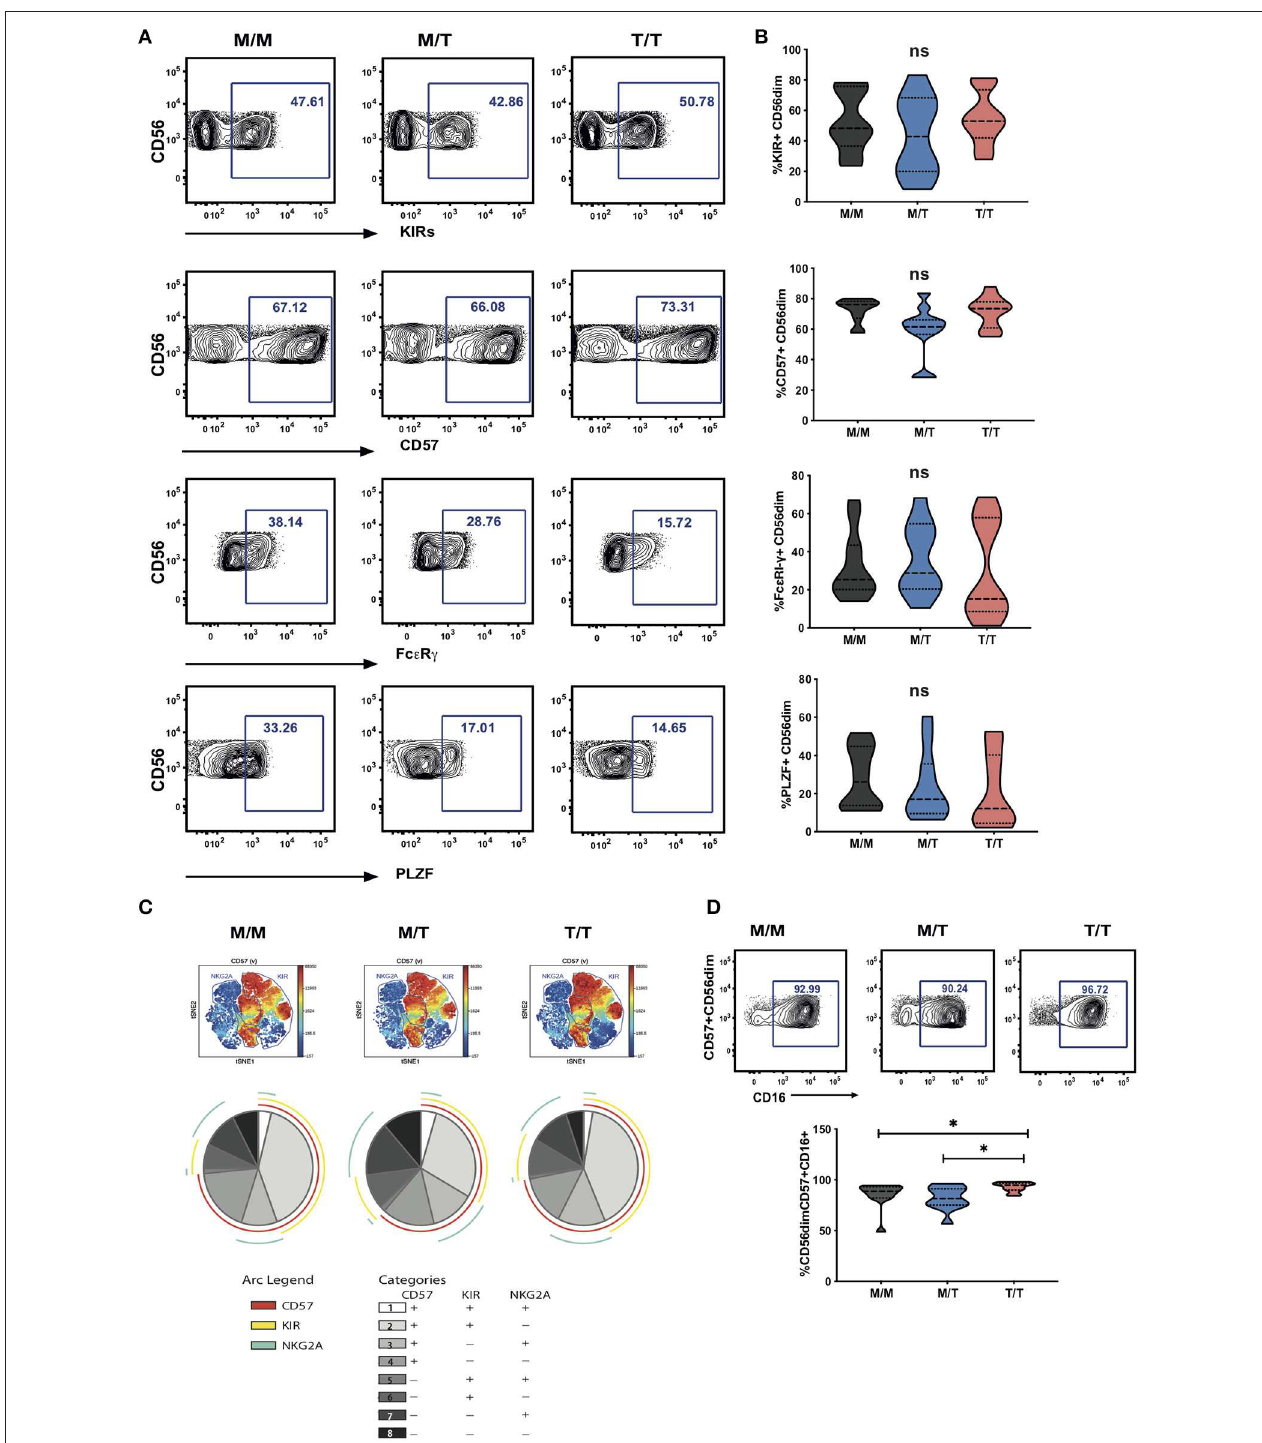
FIGURE 3 | Lack of a dominant effect of -21M HLA-B on the extent of NKG2A driven NK cell differentiation. (A) Representative contour plots depicting the gating strategy for the expression of KIRs, CD57, Fc ε RI- γ and PLZF in CD56 dim NK cells from each study group. (B) Summary violin plots of the proportion of CD56 dim NK cells expressing KIRs, CD57, Fc ε RI- γ and PLZF between donor groups. (C) ViSNE analysis of multiparametric flow data was performed on CD56 dim NK cells from the compiled M/M, M/T and T/T donors showing expression of CD57 and gated KIR and NKG2A clusters. Each point on the VisNE map represents a single cell and color depicts intensity of protein expression. SPICE analysis pie charts of CD57, KIR and NKG2A expression for each group. The pie slices represent the proportion of CD56 dim NK cells expressing different receptor combinations, and the pie arcs depict expression of individual receptors, as detailed in the key. (D) Representative contour plots and summary violin plots showing the proportion of CD57 + CD56 dim NK cells expressing CD16 between the donor groups. * p < 0.05.